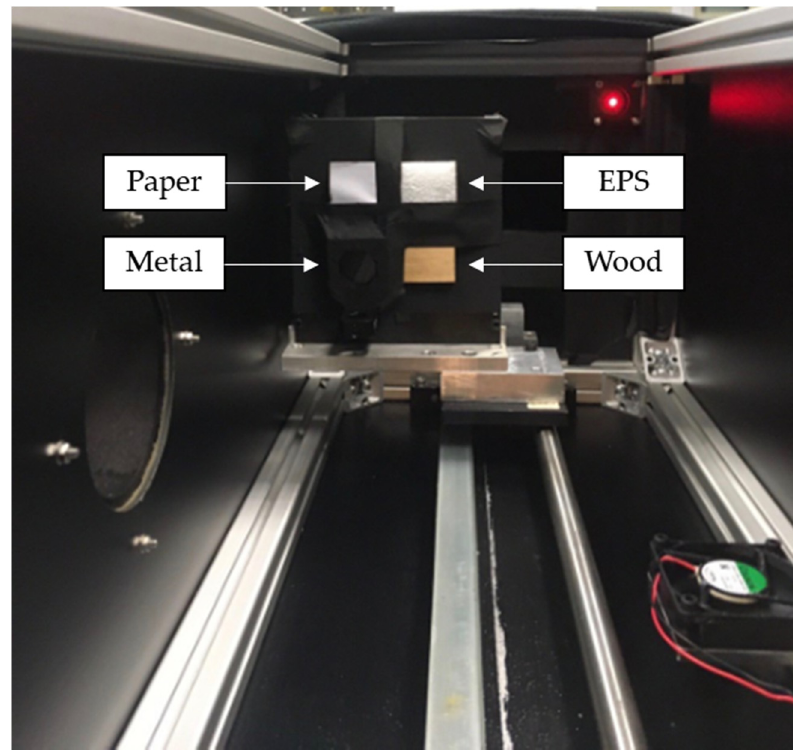
Figure 5. Test plate containing the targets of different materials inside the fog chamber. In the position top-left, there is a sample of a white sheet of paper; in top-right, a sample of gray expanded polystyrene (EPS); in bottom-left, a metallic object; and in bottom-right, a piece of wood. The plate was placed inside the fog chamber. The light intensity at the edges and the center of the plate was verified, to ensure that the illumination was evenly distributed. To do this, the test plate was connected to a magnetic ruler built into the box. The ruler was allowed to move the plate longitudinally and explore the illumination properties at dif- ferent distances. Intensity images of the setup without fog were taken. Grey levels were evaluated at different points of the images for different illumination configurations until all of the plate was evenly illuminated. The final configuration showed a deviation in an intensity below 2% between the edges and the center of the plate. For that configuration, the distance between the test plate and the illumination/detection plane was 650 mm.